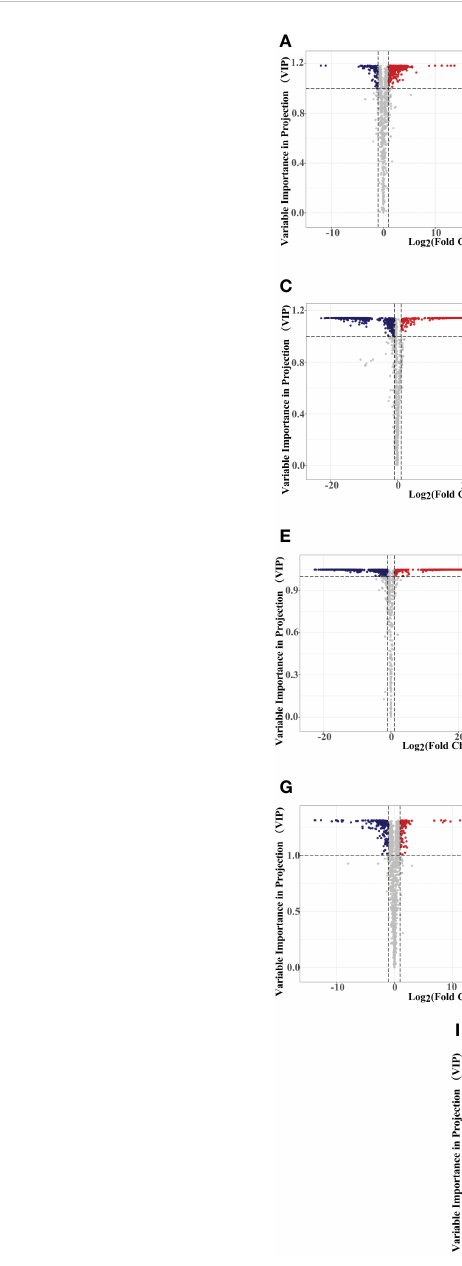
showed higher antioxidant capacity than Y-RS and Y-R. For the ABTS radical scavenging test, Q-R and Q-RP showed higher antioxidant capacity than Y-R and Y-RP, which exhibited a higher ABTS radical scavenging capacity for Q-R (49.57 ± 1.26 m M TE/g DW), which was 10-fold higher than Y-R (4.68 ± 0.45 m M TE/g DW). The ORAC values of Q-RP and Q-RS were higher than those of Y-RP and Y-RS. In addition, the average ORAC values raised in the direction: seed < pulp < berry, the rise of DPPH, ABTS, and FRAP values were berry < pulp < seed, and the DPPH average